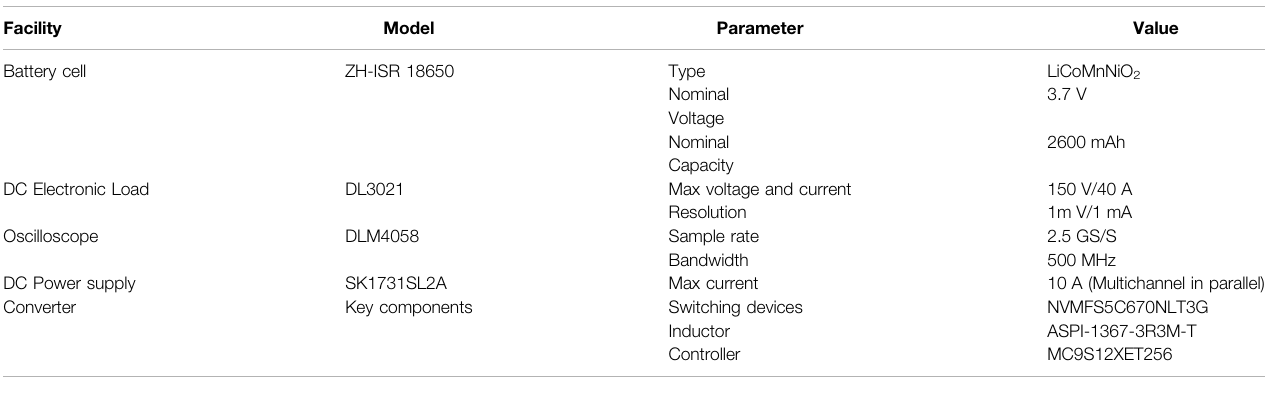
TABLE 1 | Experimental facility information.